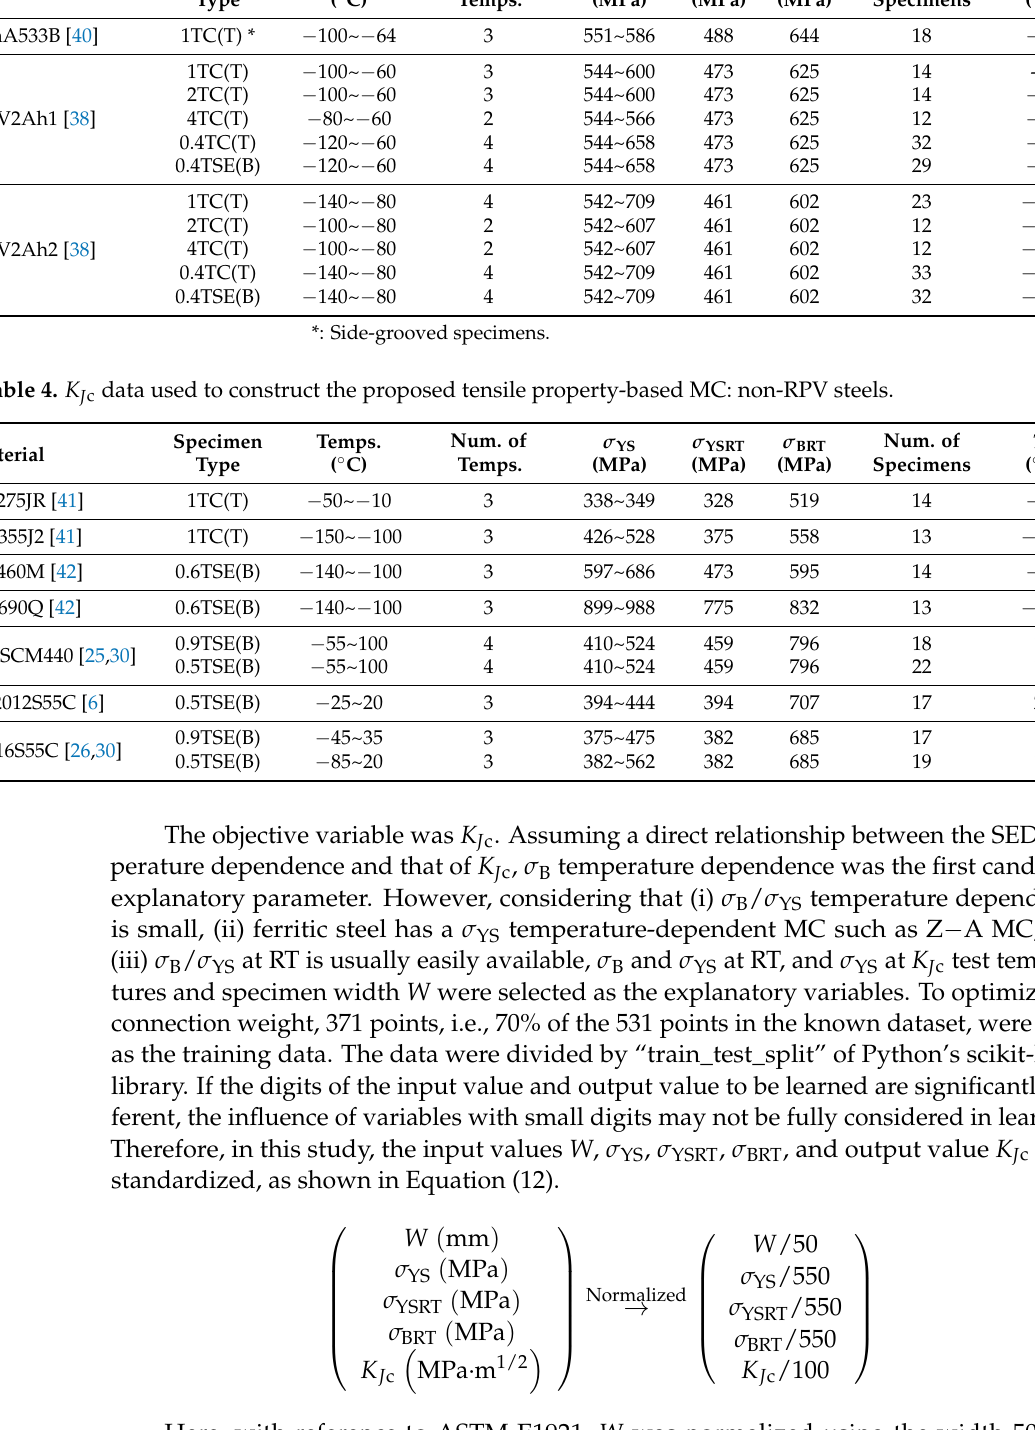
Table 3. K J c data used to construct the proposed tensile property-based K J c MC: RPV steel ASTM A533B and equivalent. Heat No.